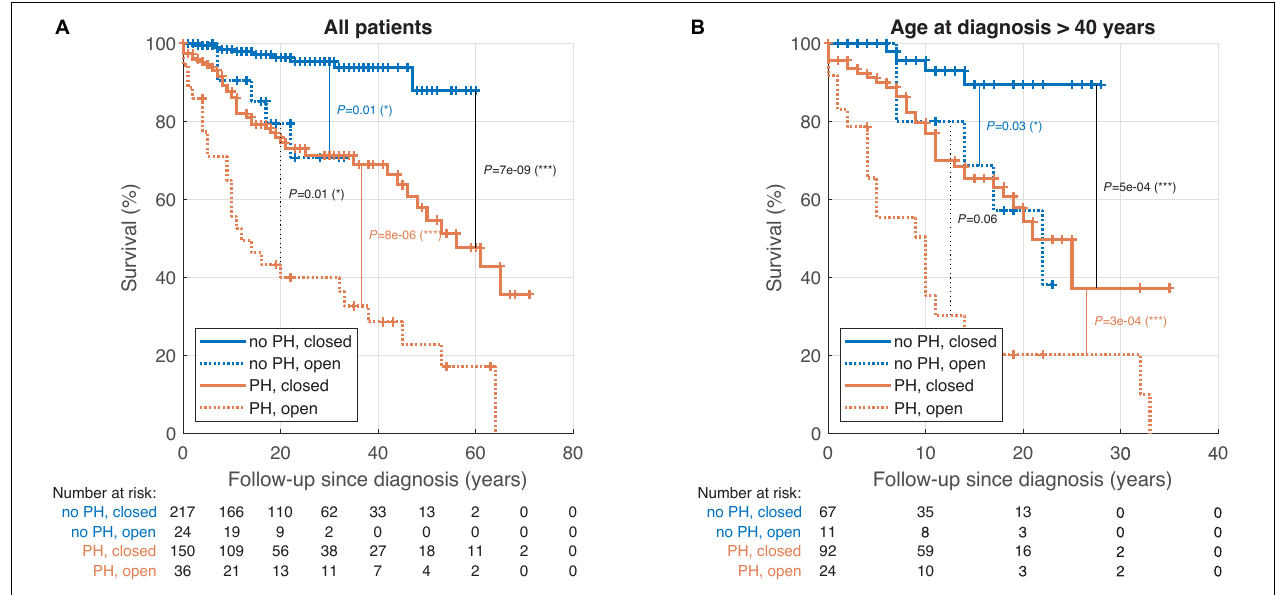
FIGURE 1 | Kaplan-Meier survival analysis of atrial septal defect (ASD) patients stratified by pulmonary hypertension (PH) and ASD closure; all patients (model A). (A) Patients of all ages. (B) Patients diagnosed at the age above 40. ASD, atrial septal defect; MR, moderate or severe mitral regurgitation; NYHA, New York Heart Association class; PH, pulmonary